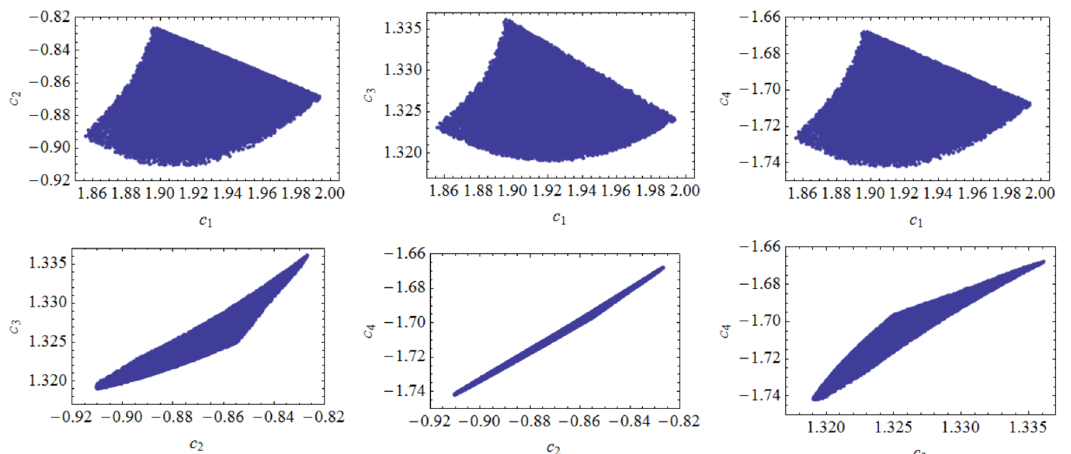
Figure 5 . Values of various UV c -parameters that reproduce the IR parameters plotted in figure 2. Here, we have chosen f = 800 GeV and g ∗ = 4